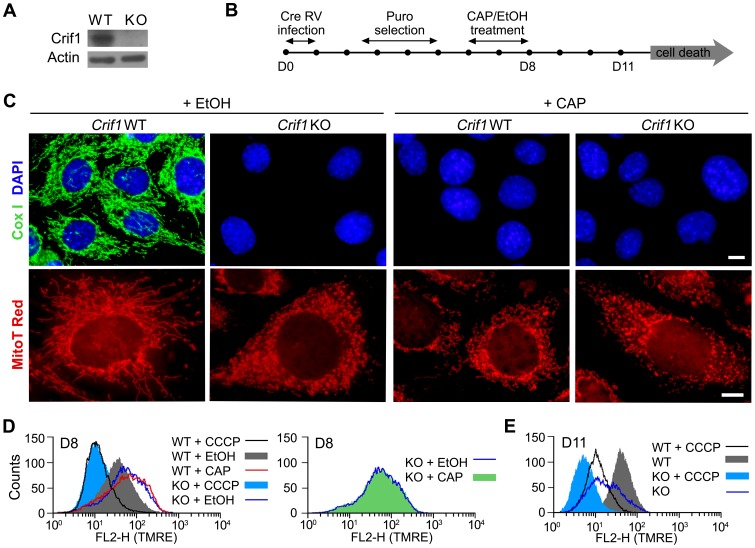

Crif1Δ/Δ and CAP treated Crif1+/+ MEFs show mitochondrial abnormalities.(A) Western blot analysis of Crif1 expression in Crif1+/+ and Crif1Δ/Δ MEFs. (B) Schematic presentation of experimental procedures. At day 0 (D0), MEFs were infected with retrovirus that expresses Cre recombinase. After puromycin selection, mitochondrial characteristics were analyzed after the treatment of either ethanol (EtOH) vehicle or chloramphenicol (CAP). (C) At day 8, cells were immunostained with Cox I antibody (in green) and DAPI (in blue) (upper panel), or stained with Mitotracker Red (bottom panel). Scale bars, 10 µm. (D, E) To measure mitochondrial membrane potential (MMP), MEFs were stained with tetramethylrhodamine ethyl ester (TMRE), a cationic fluorescent dye sensitive to MMP, and analyzed by flow cytometry on the FL2 channel at day 8 (D) and day 11 (E). Carbonyl cyanide m-chlorophenyl hydrazone (CCCP), a proton ionophore that disrupts proton gradient, was treated to gain the control peak of MMP decrease.